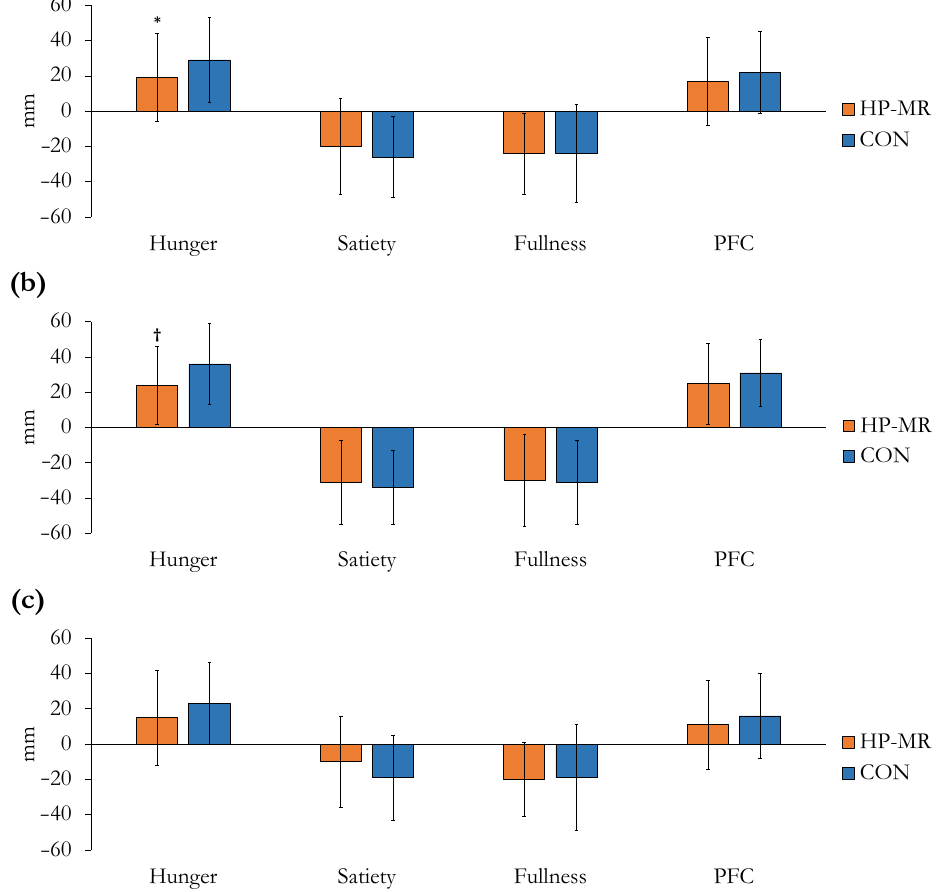
Figure 4. Changes in appetite sensations from after breakfast to after the exercise session during the HP-MR and CON intervention phases in ( a ) all participants ( n = 43), ( b ) females ( n = 19), and ( c ) males ( n = 24). Values are mean ± standard deviation. * Significant difference ( p = 0.014) in all participants ( n = 43) between the HP-MR and CON interventions, as assessed by mixed analysis of variance. † Significant difference ( p = 0.019) in females ( n = 19) between the HP-MR and CON interventions, as assessed by mixed analysis of variance. Abbreviations: CON: control, standard North American diet; HP-MR: high-protein meal replacement; PFC: prospective food consumption. No significant three-way interaction between diet, sex and time for CSS ( p = 0.322)